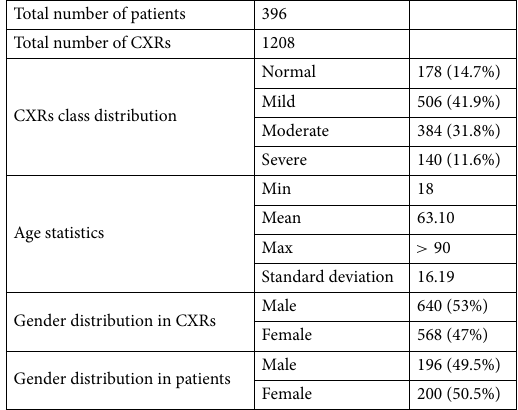
Table 1. Patients cohort utilized in the study. All the patients in this study are diagnosed with COVID-19 using RT-PCR test. CXRs for training and testing the model are chosen randomly from 1208 CXRs.